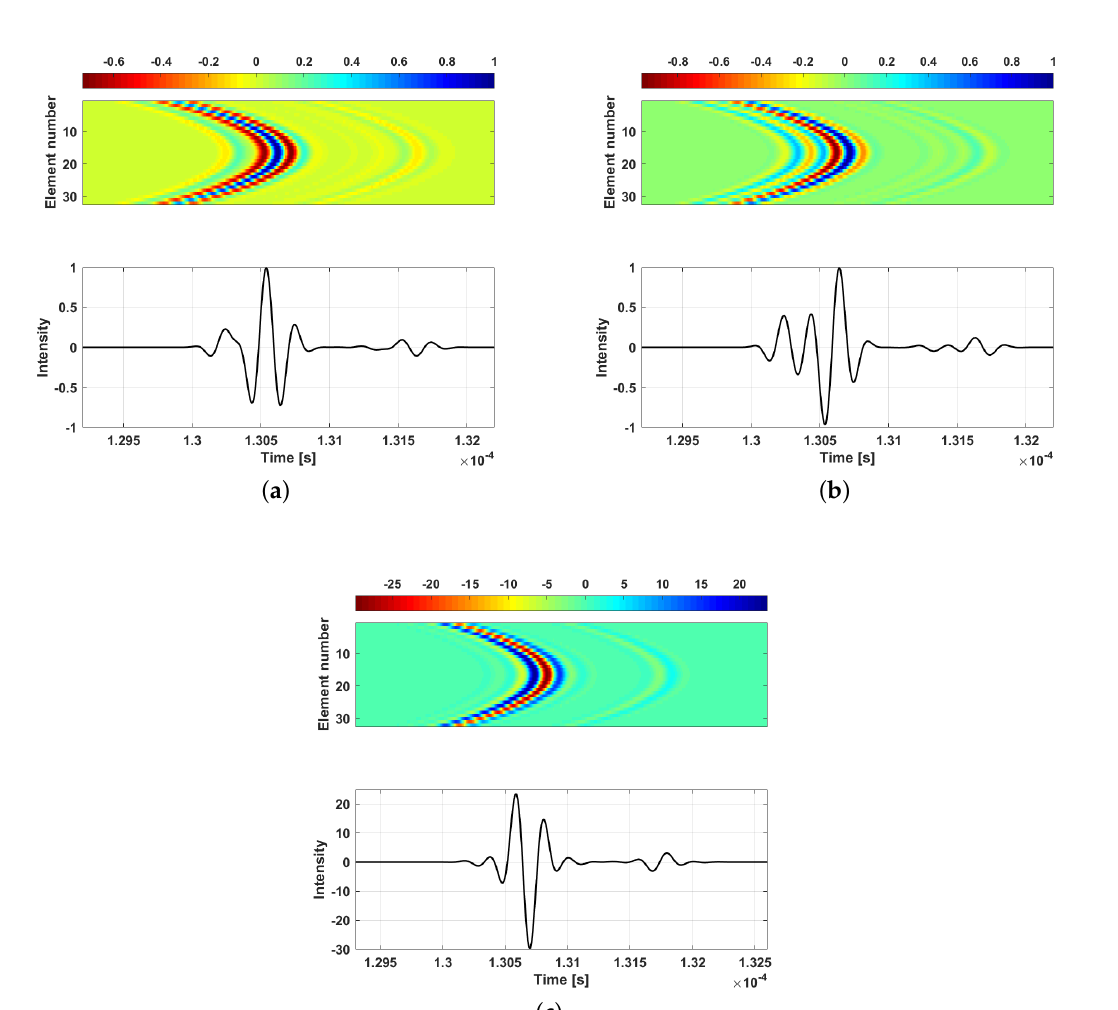
Figure 9. The 4-bit Golay code pair simulation results. ( a ) The original received 4-bit Golay code 1 intensities from the individual elements of a linear array transducer (top) and the individual response of center element (bottom). ( b ) The original received 4-bit Golay code 2 intensities from the individual elements of a linear array transducer (top) and the individual response of center element (bottom). ( c ) The compressed signals from the individual elements of a linear array transducer (top) and the compressed signal of center element